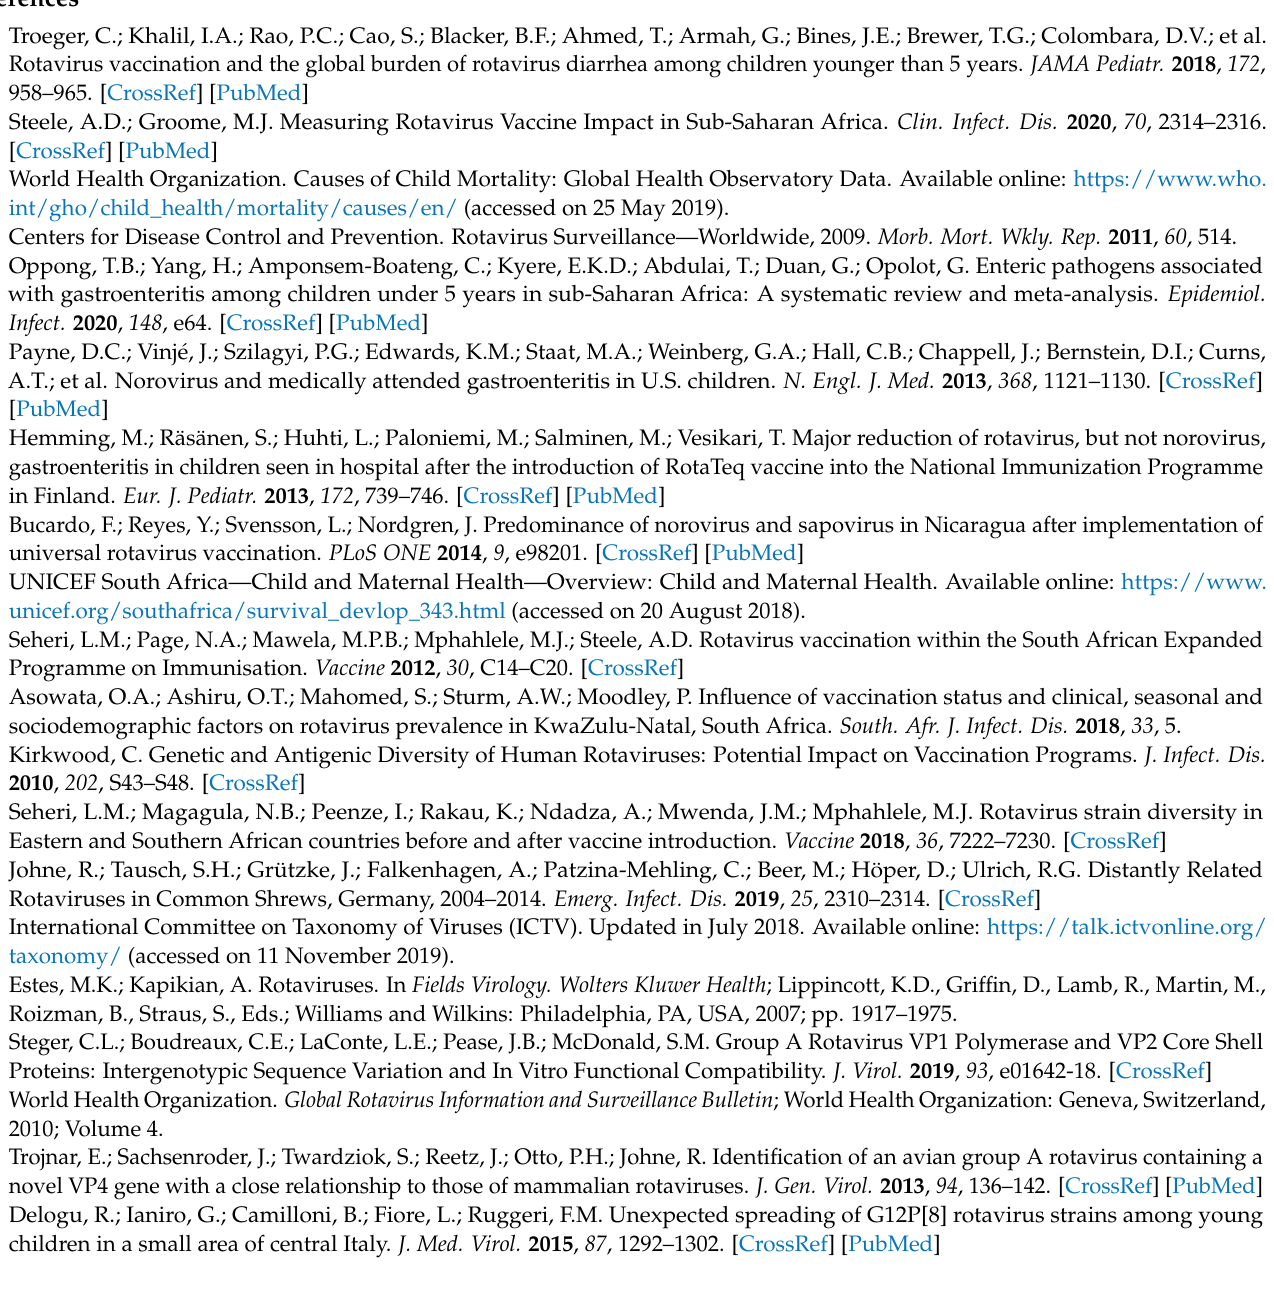
Figure S6: Rotavirus G genotype distribution pre- and post-vaccine introduction in South Africa (1982–2020), Figure S7: Rotavirus P genotype distribution pre- and post-vaccine introduction in South Africa